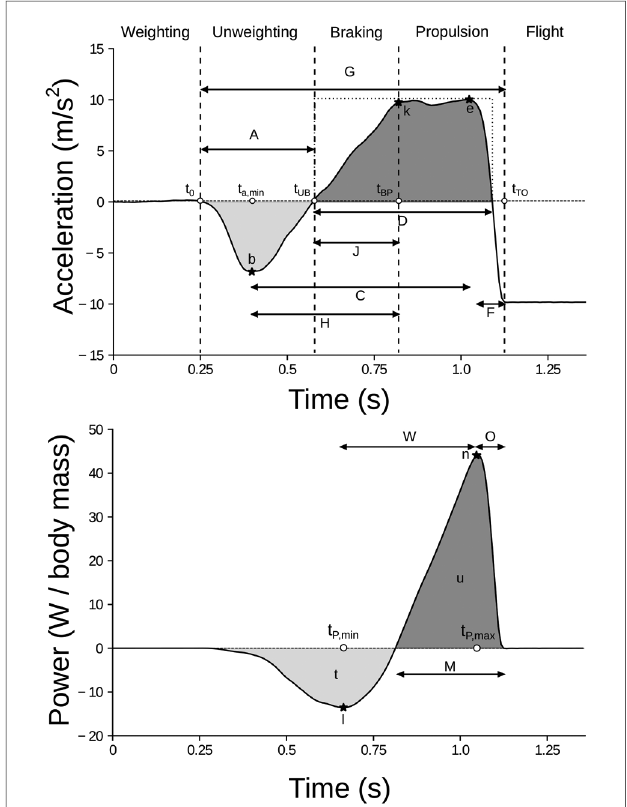
FIGURE 3 Visual depiction of the selected features, for a representative jump. Acceleration-related features are shown in the top panel, while power- related ones in the bottom panel. The vertical dotted lines in the top panel represent jump-phases transitions (1): the weighting phase lasts from the beginning to t 0 (jump onset); the unweighting phase lasts from t t t t 0 to UB ; the braking phase lasts from UB to BP ; the propulsion phase lasts from t BP to t TO . Notice that t UB and t v ,min coincide. For the sake of clarity, only the former was depicted. Feature i cannot be represented as its numerical value was derived from further computations. The meaning of each feature is detailed in Table 1